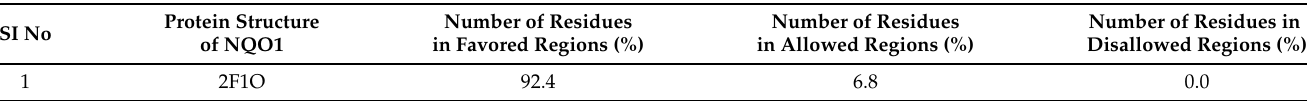
Table 3. The values found from RAMPAGE represents the number of residues in favored region, allowed region and outliner regions through Ramachandran plot evaluation centre and the outliner regions through the RAMPAGE evaluation